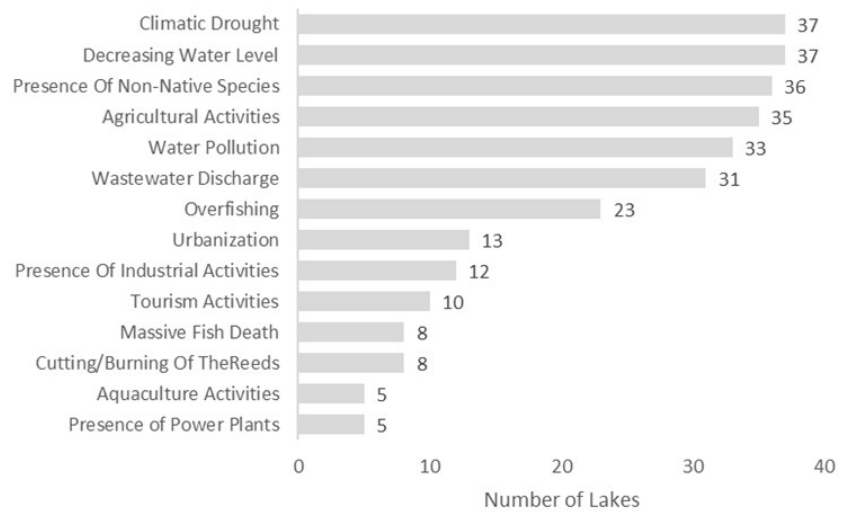
Figure 4. Frequencies of occurrence of the 14 main threats in the examined Turkish lakes.